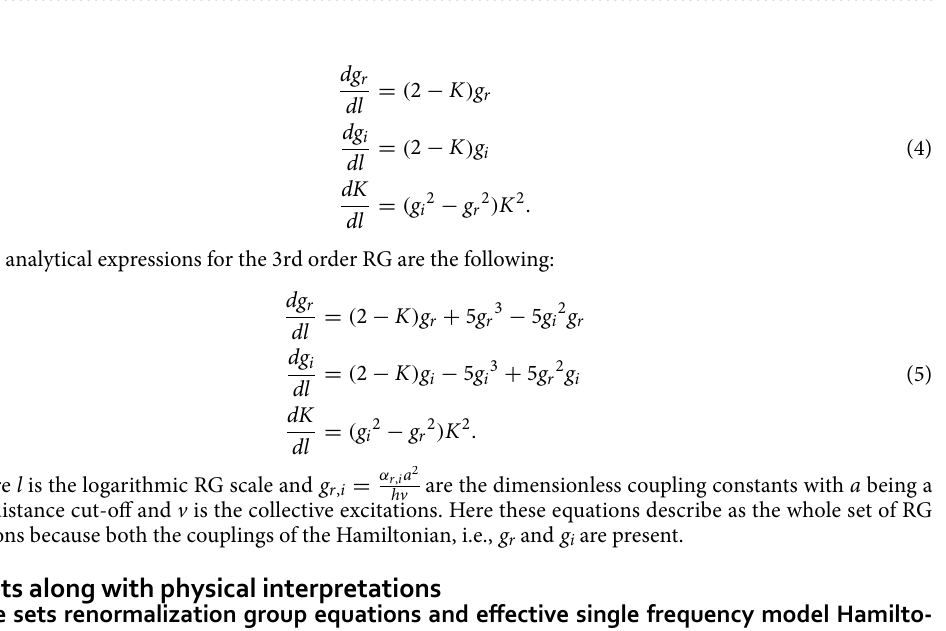
Figure 1. These figures show renormalization group flow diagram for the couplings g r with g i , for two different initial values of K ( = 1, 2.5 ) . The upper and lower panels are for the third order (Eq. 5) and second order (Eq. 4) RG equations solutions,